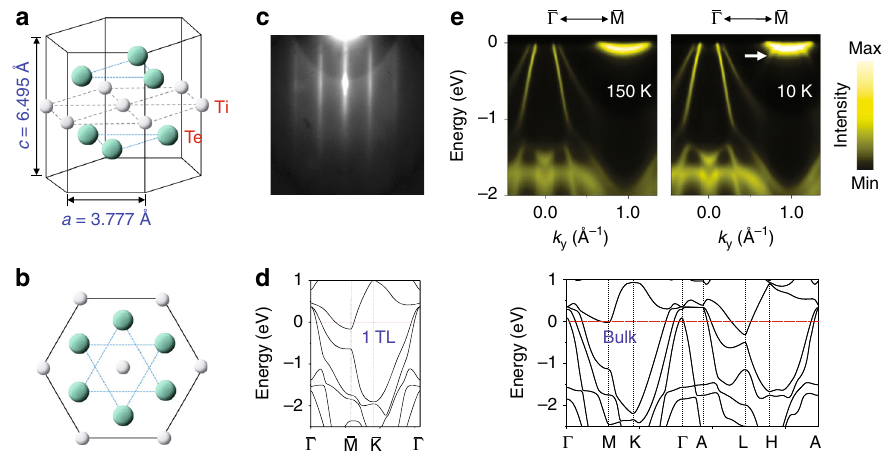
Fig. 1 Crystal structure and electronic band structure of single-layer TiTe 2 . a Atomic structure of a single layer of TiTe 2 . The quantities a and c are the lattice constants of bulk TiTe 2 taken from ref. 13 . b Same structure projected onto the (0001) plane. c A RHEED pattern taken after fi lm growth. The spacings between streaks yield a measure of the lattice constant. d Calculated band structure for a 1-TL and bulk TiTe 2 using the GGA method. e ARPES spectra taken from a 1-TL TiTe 2 along the Γ - M direction for the normal phase at 150 K and the (2 × 2) CDW phase at 10 K. The arrow points at features correspond to (2 × 2) folded valence